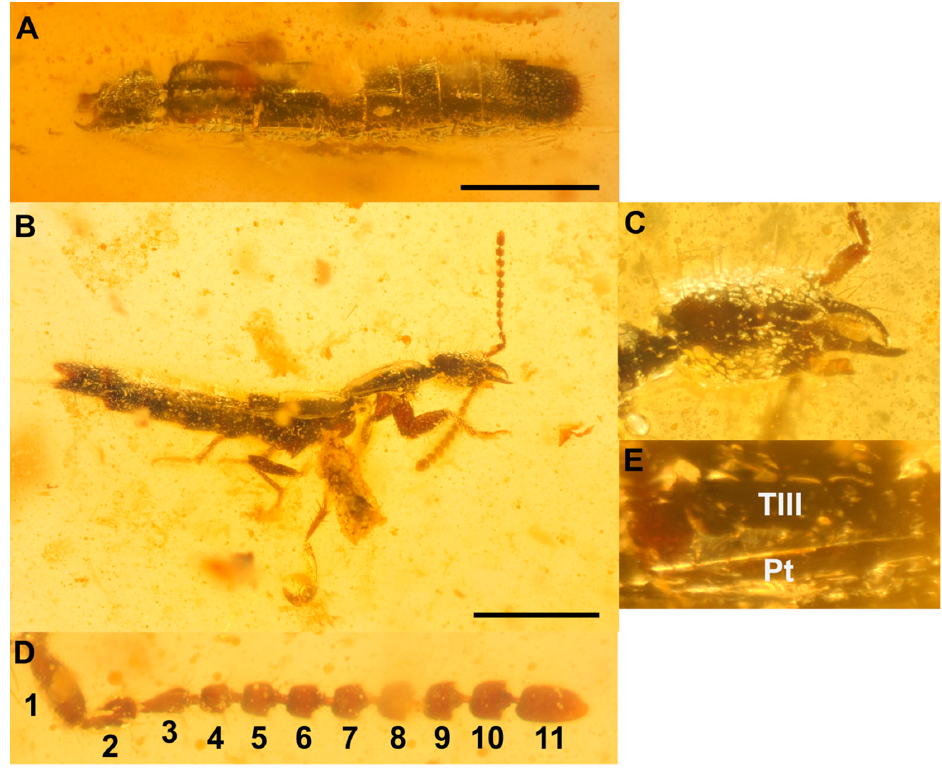
Figure 3. Coomania enkarsios sp. nov. Holotype SNUC-Paleo-0105. ( A ), dorsal view. ( B ), lateral view. ( C ), close up of head and mandibles. ( D ), right antenna. ( E ), tergite III with paratergite. Scale bars- 1 mm. TIII-tergite III; Pt-paratergite.